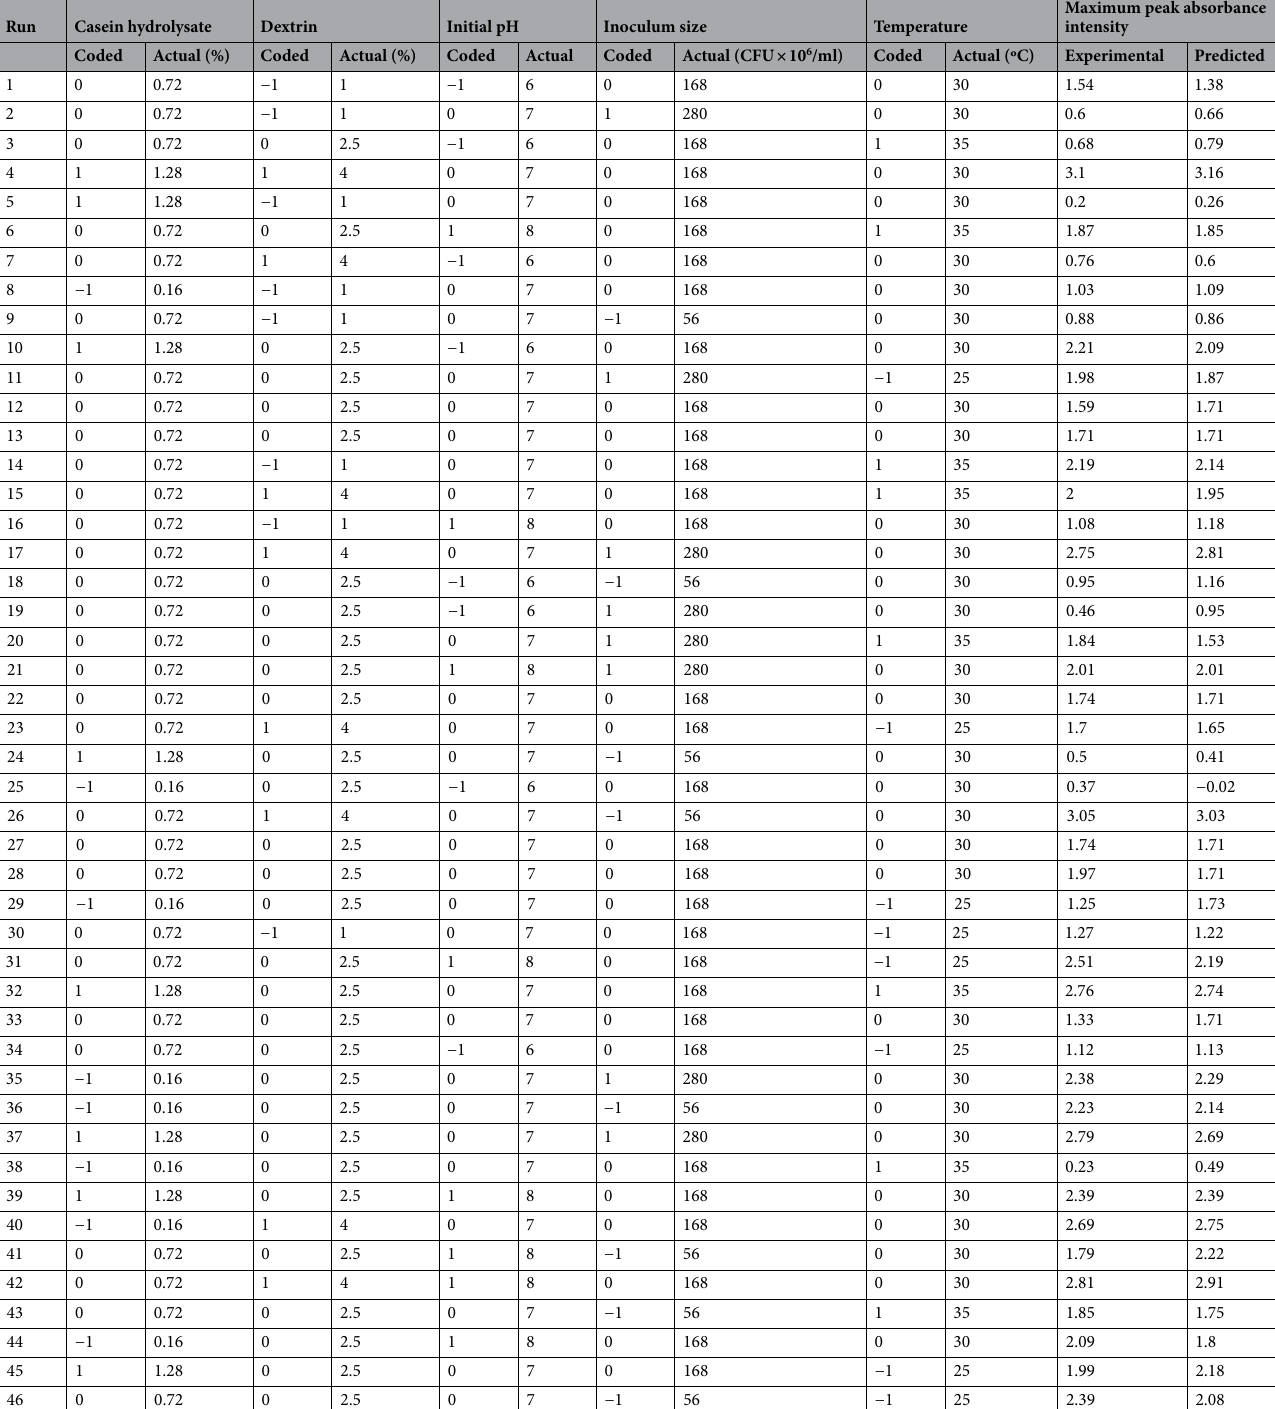
Table 4. BBD used for AuNPs biosynthesis, using Bacillus subtilis NRC1 extracellular